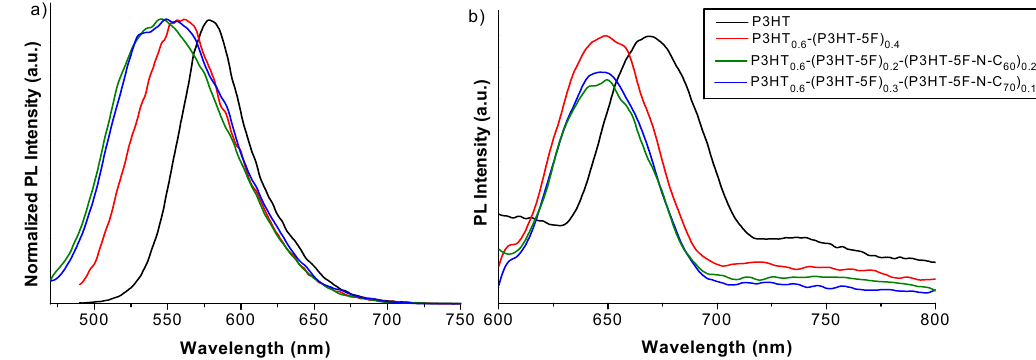
Figure 9. Photoluminescence spectra of: ( a ) o -DCB solutions; and ( b ) in film form of un functionalized rr- P3HT, side functionalized [P3HT 0.6 -(P3HT-5F) 0.4 ], [P3HT 0.6 -(P3HT-5F) 0.2 -(P3HT-5F-N-C 60 ) 0.2 ] hybrid and [P3HT 0.6 -(P3HT-5F) 0.3 -(P3HT-5F-N-C 70 ) 0.1 ] hybrid, respectively.